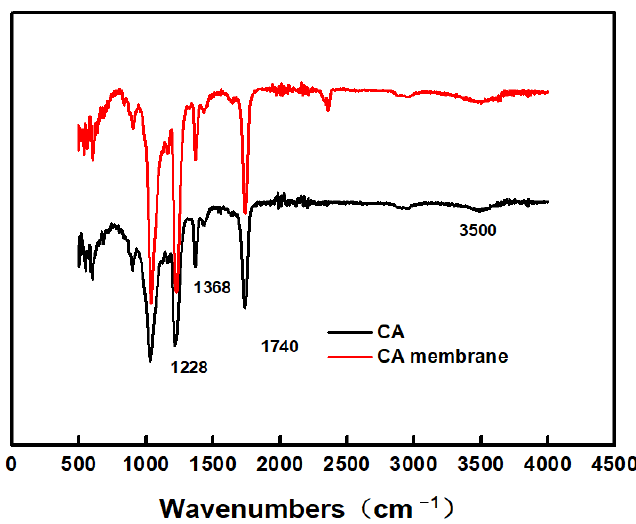
Figure 1. The FT-IR spectra of CA material and CA membrane.